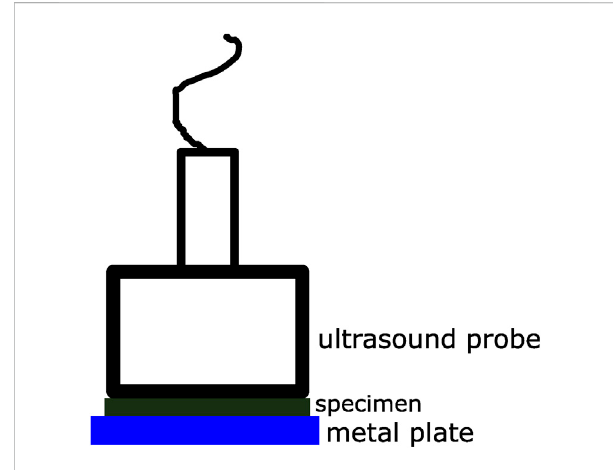
FIGURE 1 Schematic of the ultrasound probe, specimen, and metal plate during acoustic